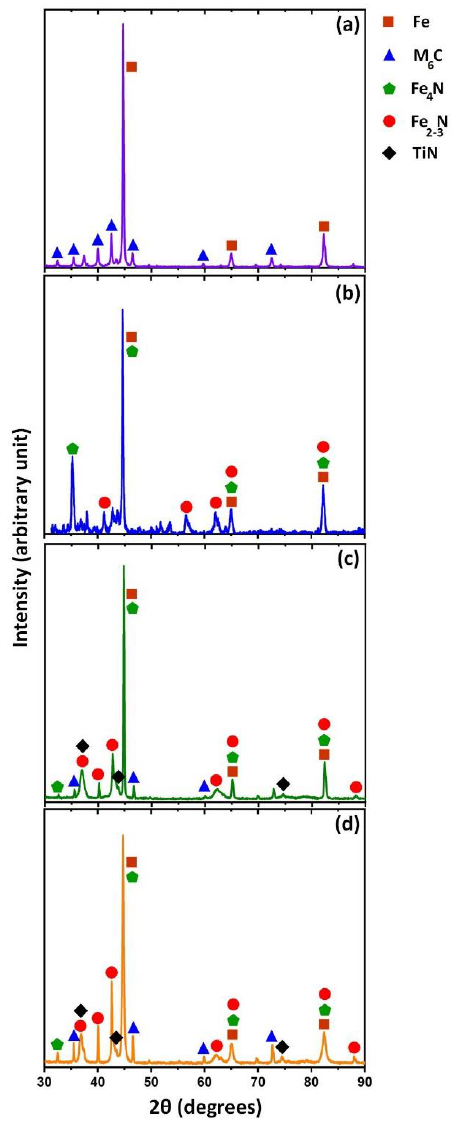
Figure 2. Conventional X-ray diffraction of ( a ) base sample, ( b ) CPN, and duplex-treated samples with substrate temperature for TiN deposition at ( c ) 400 °C and ( d ) 450 °C.